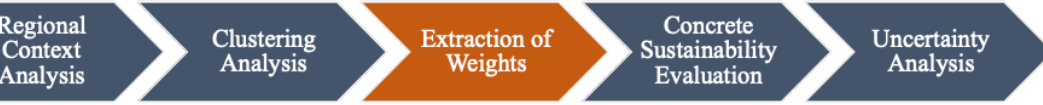
Figure 1. Analytical flow.